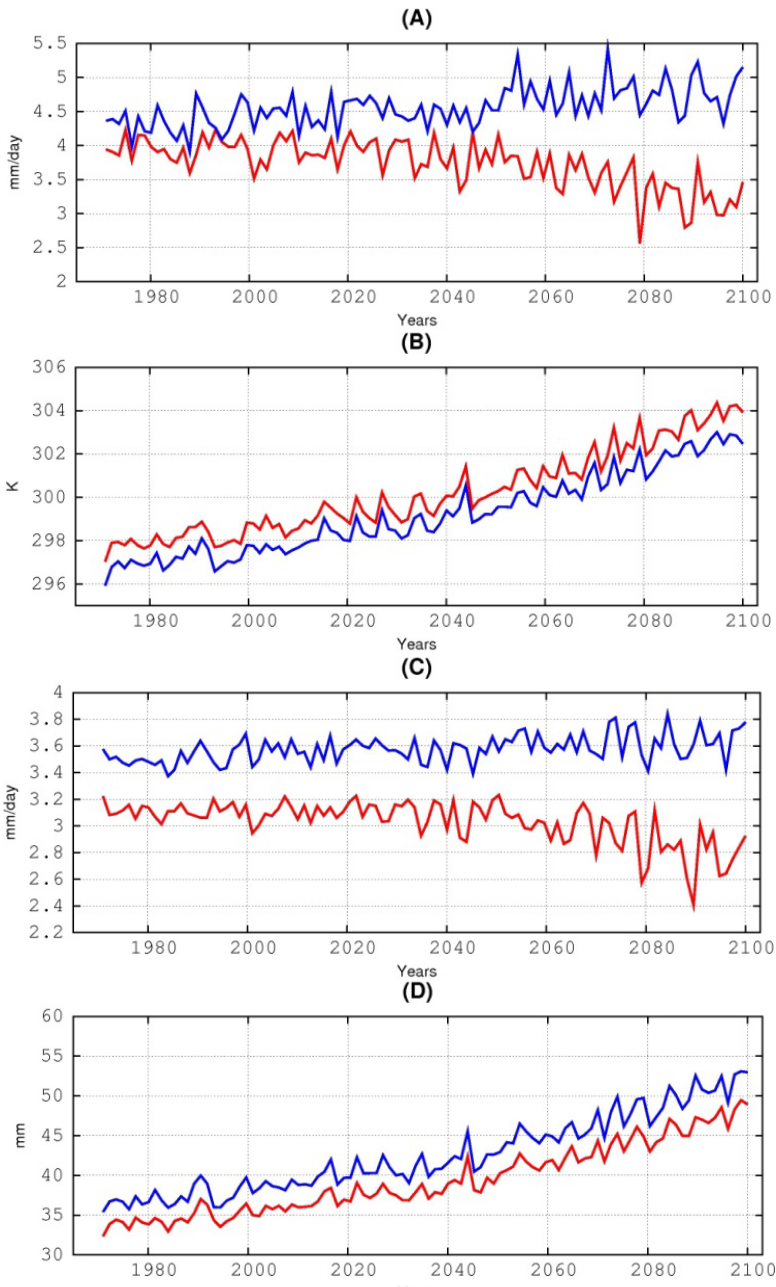
Figure 2. Red (REMO) and Blue (MPI-ESM) curves represent annually averaged values over the region 15°E–30°E; 8°S–10°N for RCP 8.5. The panels show ( A ) Precipitation in mm/day, ( B ) 2m Temperature in Kelvin, ( C ) Evapotranspiration in mm/day and ( D ) Vertically integrated specific humidity in